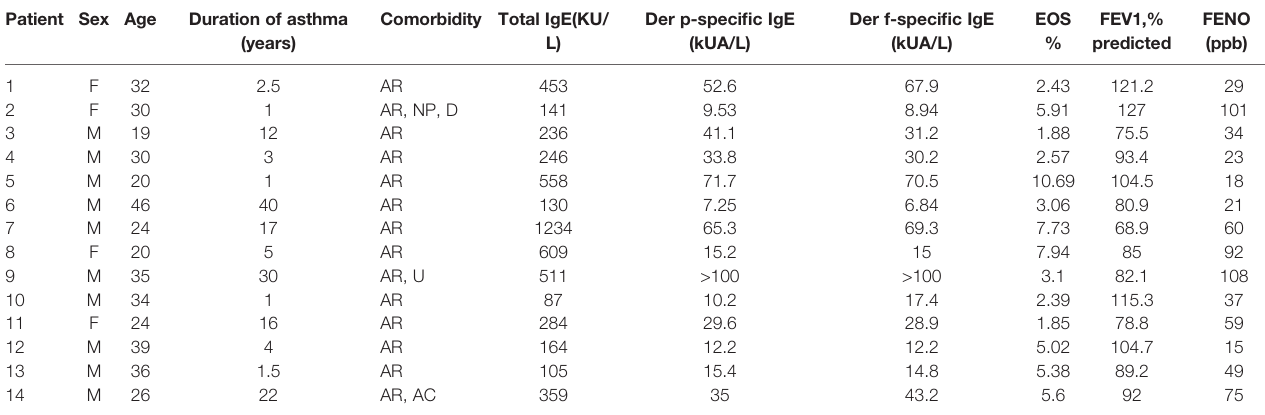
TABLE 1 | Patient demographics for ex vivo